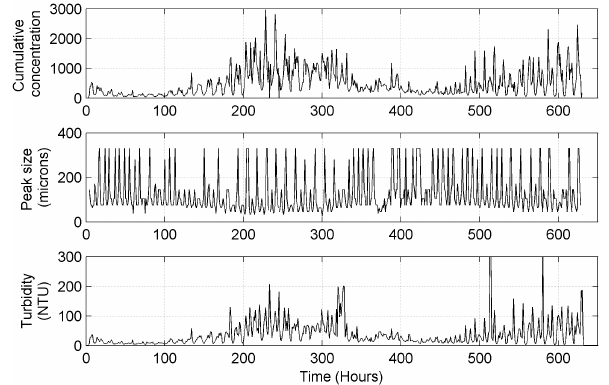
Figure 6. Time series of integrated parameters from the LISST. Top panel is the concentration. Second panel is the peak size. Third panel is the turbidity from the OBS sensor.